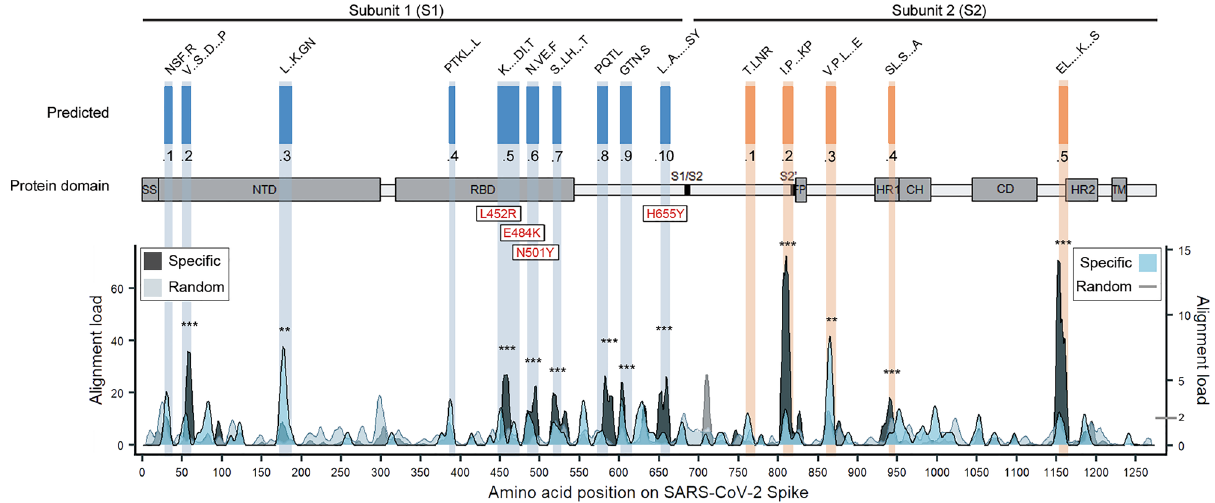
Figure 1. MVA-defined epitopes on SARS-CoV-2 spike protein. Alignment profiles of the most abundant and common immune response features from MVA immunoprofiling data of COVID-19 naïve subjects (n = 538), including altogether 22,949 unique epitopes characterising core motif sequences (hypergeometric p-value < 10 –3 for core epitope recognition) on the primary sequence of SARS-CoV-2 S protein (UniProtKB code: P0DTC2). The abundance of aligned core epitope sequences (black Specific, primary y-axis) in peaks was significantly higher (**p < 0.01, ***p < 0.001) compared to random alignment (light gray random, primary y-axis). Of aligned core epitopes, 111 were with exact matches in all amino acid positions (blue specific, secondary y-axis). Regions of primary sequence with alignment load of > 2 motifs (the calculated theoretical random) (gray random line, secondary y-axis) were considered as potentially immunogenic and included in further analysis. Alignment profiles were visualised as centred moving averages across 9 amino acids. 15 epitopes (designated S1.1….10 on subunit 1 of S (S1) and S2.1….5 on subunit 2 of S (S2)) from MVA data analysis (predicted) were defined on SARS-CoV-2 S protein (x-axis) with representative consensus sequences shown. Common mutations observed in emerging SARS-CoV-2 variants were mapped to MVA-identified S epitopes and highlighted with red labels. Most common variants with enhanced transmissibility of SARS-CoV-2 variants with L452R, E484K/Q, and H655Y mutations 99,109,123 encompass epitopes in S1.5, S1.6, or S1.10 respectively. Primary y-axis—abundance of specific- vs random-aligned sequences with ≥ 4 matching positions (includes also exactly-matching sequences). Secondary y-axis—abundance of aligned motif sequences with all positions matching. SARS-CoV-2 S protein domains are adapted from Wrapp et al. 54 with additional information on RBD from Yuan et al. 53 . SS